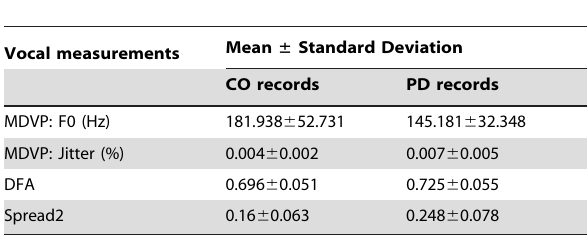
Table 1. Statistics of the vocal measurements selected by the sequential forward selection (SFS)